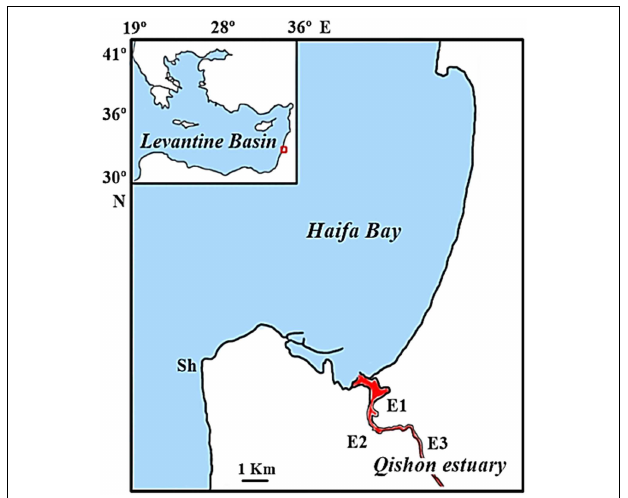
FIGURE 1 | Map of the station locations: E1–E3 are situated along the Qishon estuary and station Sh is located off the Israeli coast.